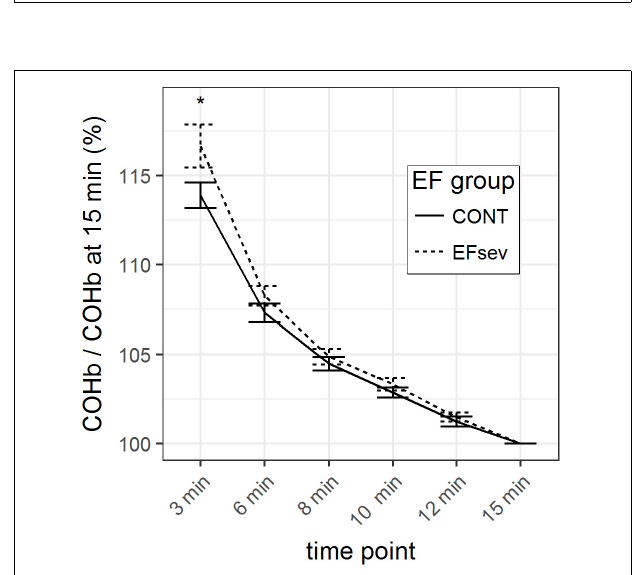
FIGURE 2 | Course of carboxyhemoglobin (COHb) in capillary blood within 15 min after rebreathing of carbon monoxide (CO) using the optimized CO rebreathing method (oCORM), normalized to value at 15 min after rebreathing. ∗ indicates statistical significant contrast between groups. Data provided as mean and standard